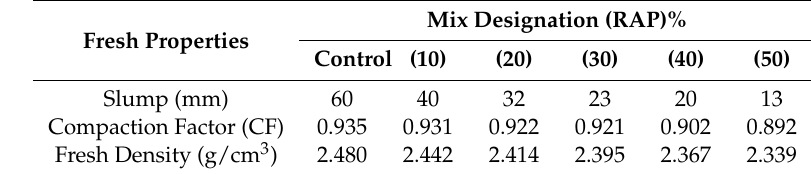
Table 6. Fresh properties of RHA concrete mixes. Table 7. Fresh properties of RAP concrete mixes.